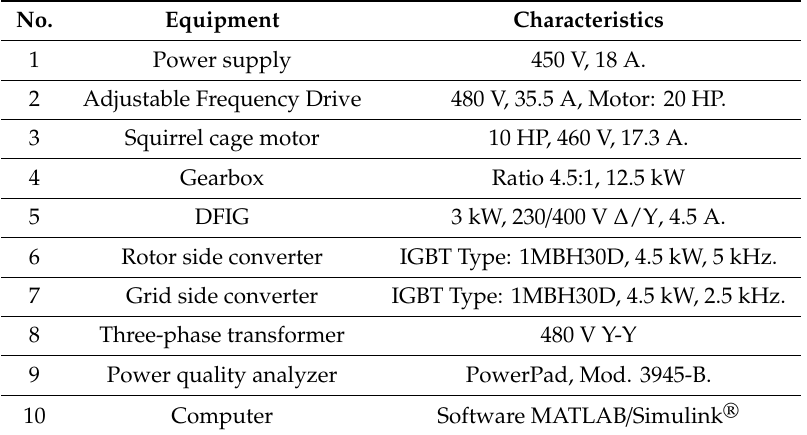
Table 2. Parameters of the experimental